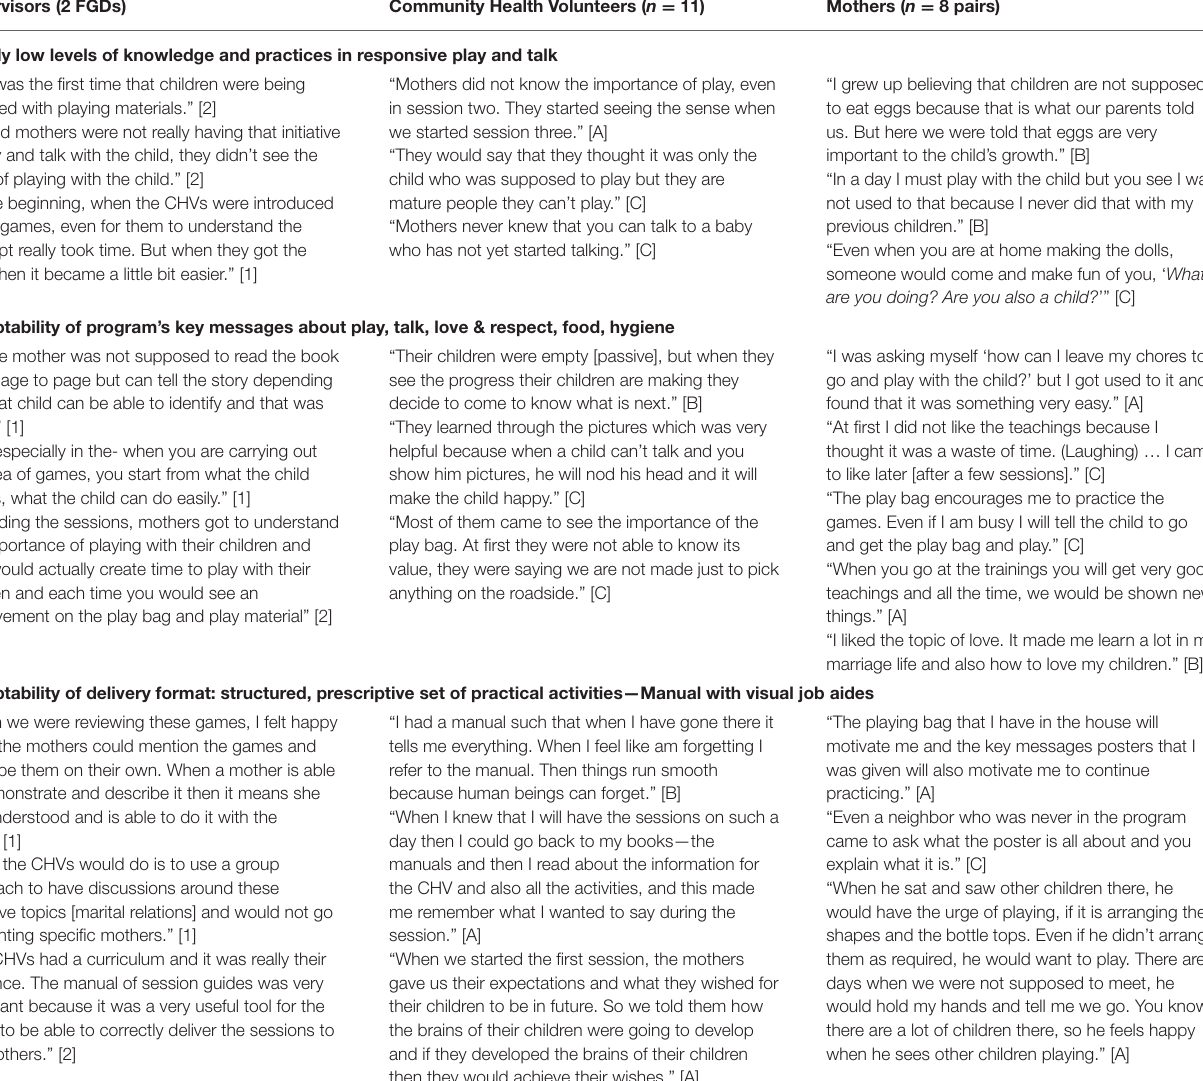
TABLE 2 | Illustrative participant responses regarding need for and acceptance of the designed program. Supervisors (2